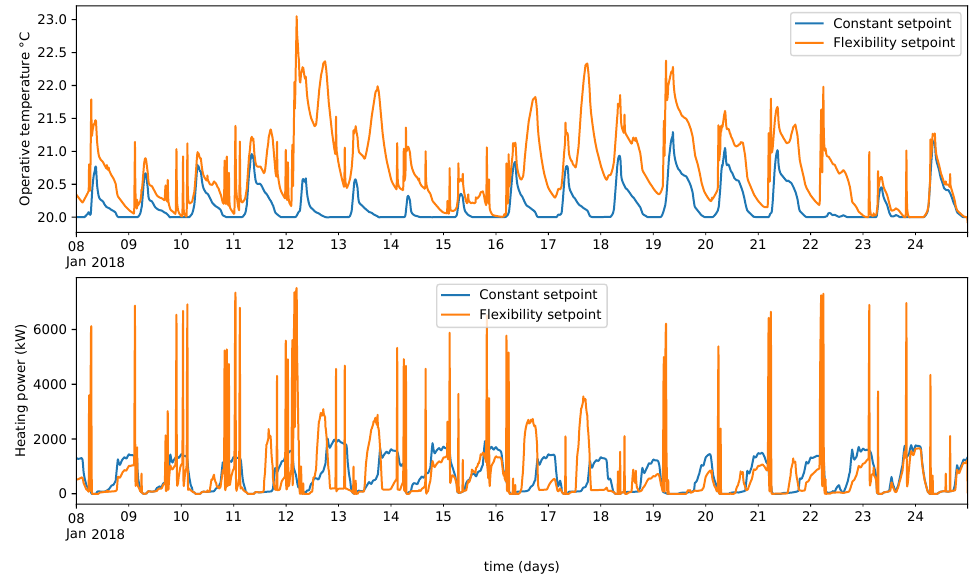
Figure 18. Modelica simulations—comparison between control scenarios. Table 2. Performance indices with flexibility scenario to optimize CO 2 emissions against constant temperature